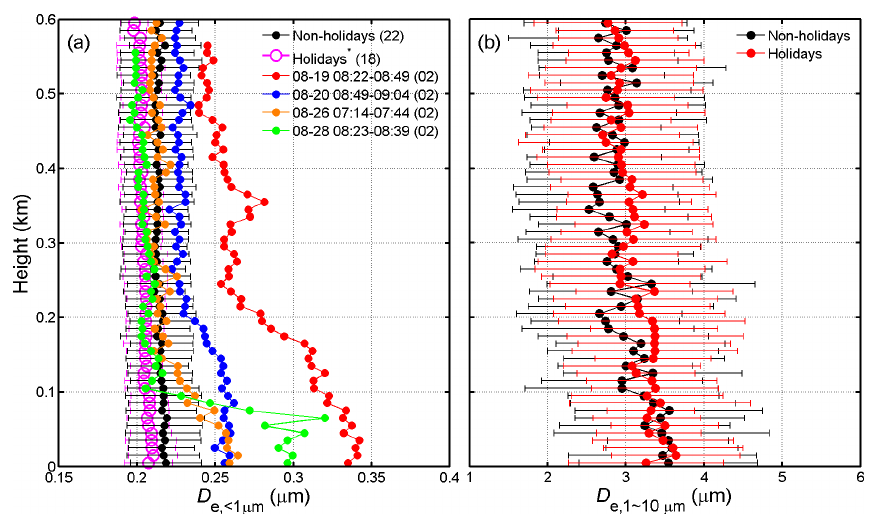
Figure 5. (a) Average vertical profiles of D e ,< 1µm for different cases. Solid black dots are for non-holidays, magenta circles are for religious holidays excluding samples in the mornings, and various colored solid dots are for religious holiday mornings. (b) Average vertical profiles of D e , 1–10µm for non-holidays (black dots) and holidays (red dots). The number of profiles collected during the period of each case is given in parentheses.